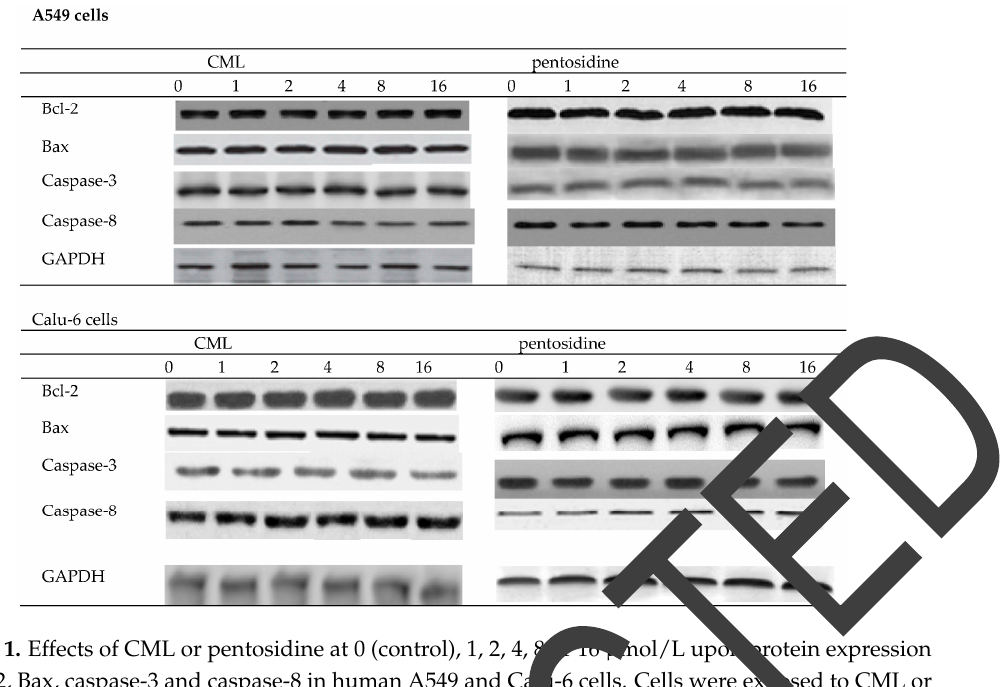
Figure 1. Effects of CML or pentosidine at 0 (control), 1, 2, 4, 8 or 16 μ mol/L upon protein expression of Bcl-2, Bax, caspase-3 and caspase-8 in human A549 and Calu-6 cells. Cells were exposed to CML or pentosidine for 18 h at 37 °C. Data are mean ± SD ( n = 10). Table 2. Effects of CML or pentosidine at 0 (control), 1, 2, 4, 8 or 16 μ mol/L upon cell invasion (% of control) and migration (% of control) in human A549 and Calu-6 cells. Cells were exposed to CML or pentosidine for 18 h at 37 °C. Data are mean ± SD ( n = 10). a–e Means within a column without a common letter differ, p < 0.05.